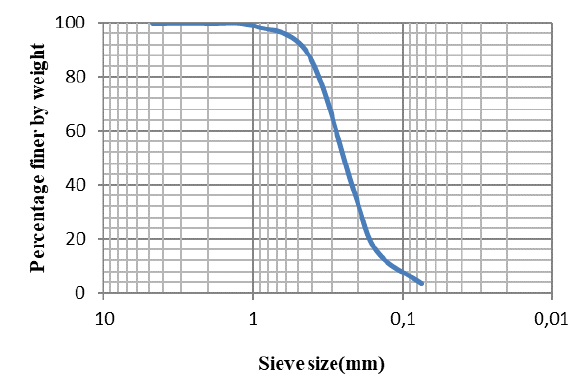
Figure 2: Particle size distribution curve.